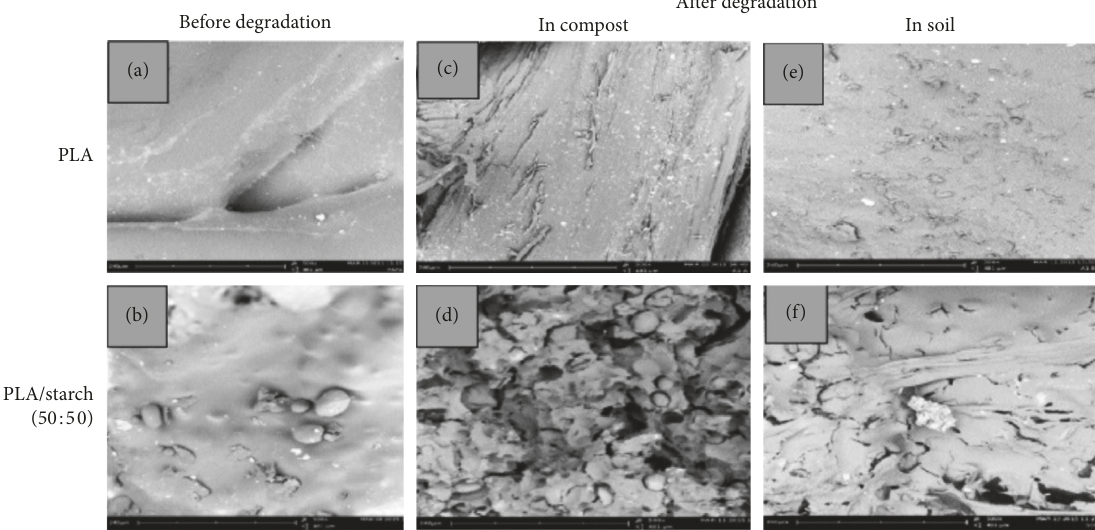
Figure 2: SEM images of PLA and PLA/starch (50/50) composite samples surface before degradation (a and b), after degradation in compost (c and d), and after degradation in soil (e and f) for 14days (adapted with permission from ref. [24]).